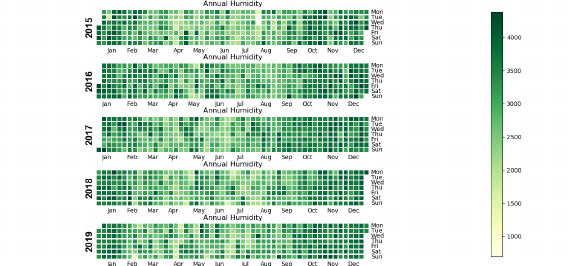
Figure 1: Annual humidity data value per day over the years (2015 to